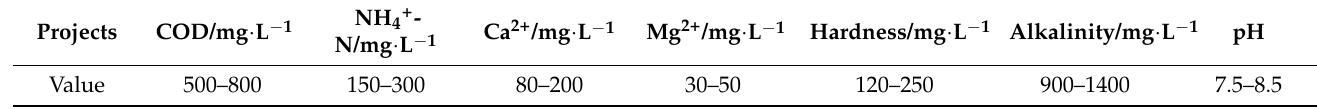
Table 1. Physicochemical characteristics of the high-ammonia-nitrogen wastewater.